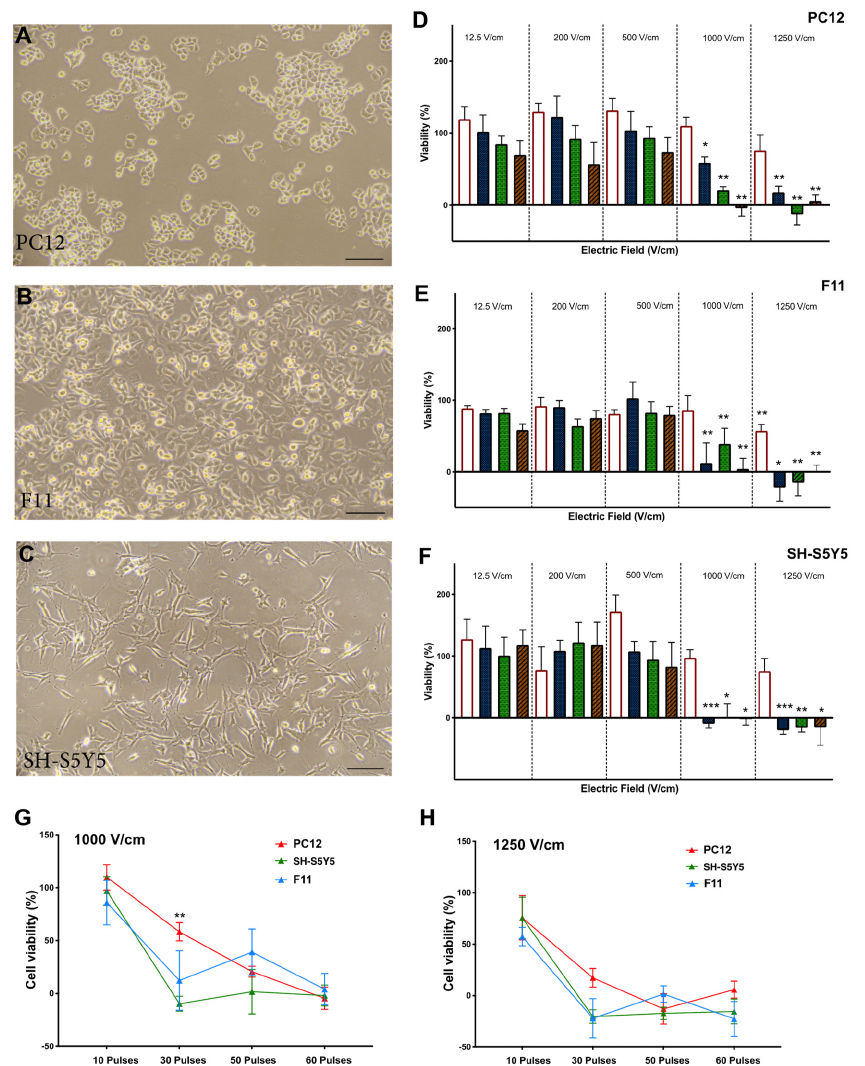
Figure 2. Neuronal viability is reduced by increasing electric field strength. The percentage of cell viability was normalised against control cells (no electroporation) in PC12 ( A ), F11 ( B ), and SH-S5Y5 ( C ) cells. ( D ) In PC12 suspension cells, there was a significant difference at 1000 and 1250 V/cm at 30, 50, and 60 pulses. ( E ) In F11 suspension cells, the cell viability was significantly reduced at 1000 V/cm of 30, 50, and 60 pulses and at 1250 V/cm at 10, 30, 50, and 60 pulses. ( F ) In SH-S5Y5 cells, at 30, 50, and 60 pulses cell viability significantly reduced. While the origin of these neuronal cell lines is different, no significant difference was observed at the threshold field strength of 1000 V/cm ( G ) and 1250 V/cm ( H ) among the neuronal lines with the exception of the difference between PC12 and SH-S5Y5 at 30 pulses. All data shown as mean ± SEM. Statistical significance performed using paired t-test and two-way ANOVA (* p < 0.05, ** p < 0.005, *** p < 0.001). Scale bar is 100 μ m.